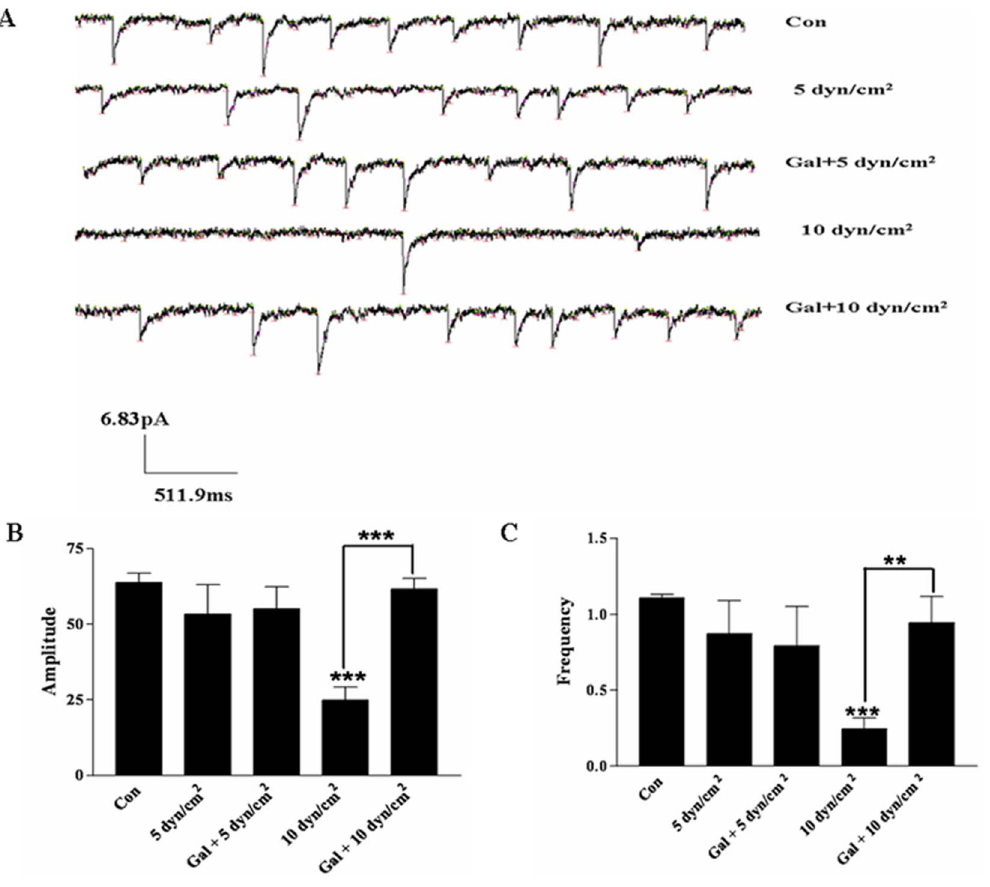
Figure 6. Effect of galanin on the excitatory postsynaptic currents (EPSCs) after shear stress. A) EPSC of cultured cortical neurons after shear stress of 5 dyn/cm 2 and 10 dyn/cm 2 by patch clamp assay. B) Shear stress of 5 dyn/cm 2 for 12 h can not cause a significant change in amplitude. But shear stress of 10 dyn/cm 2 for 12 h cause significantly decrease the amplitude, and pretreatment of galanin cause a significant increase in amplitude. C) Frequency of cortical neurons after galanin treatment. Shear stress of 5 dyn/cm 2 for 12 h can not cause a marked decrease in frequency, but shear stress of 10 dyn/cm 2 for 12 h induced a significant decrease in frequency, while galanin increased the frequency of cortical neurons after shear stress with 10 dyn/cm 2 . * p , 0.05, ** p , 0.01 and *** p , 0.001 were considered to be statistically significant.